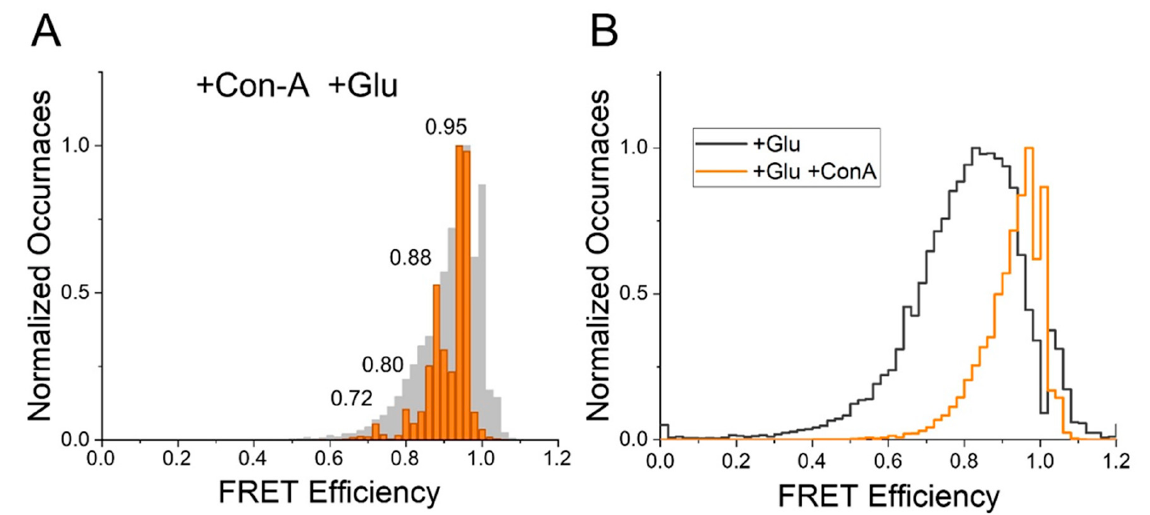
Figure 2. Conformational landscape of the distance across the dimer–dimer interface at the amino-terminal domain (ATD) of the homomeric GluK2 receptor (measured at site 266). ( A ) Denoised FRET efficiency histogram, in orange, overlapped onto an observed FRET efficiency histogram, in gray, depicting FRET efficiency occurrences in the presence of Con-A and glutamate. ( B ) Comparison between observed FRET efficiency histograms for glutamate-bound homomeric GluK2 receptors in the absence (in black) [34] and presence (in orange) of Con-A, illustrating a shift toward higher FRET efficiencies in the presence of Con-A.